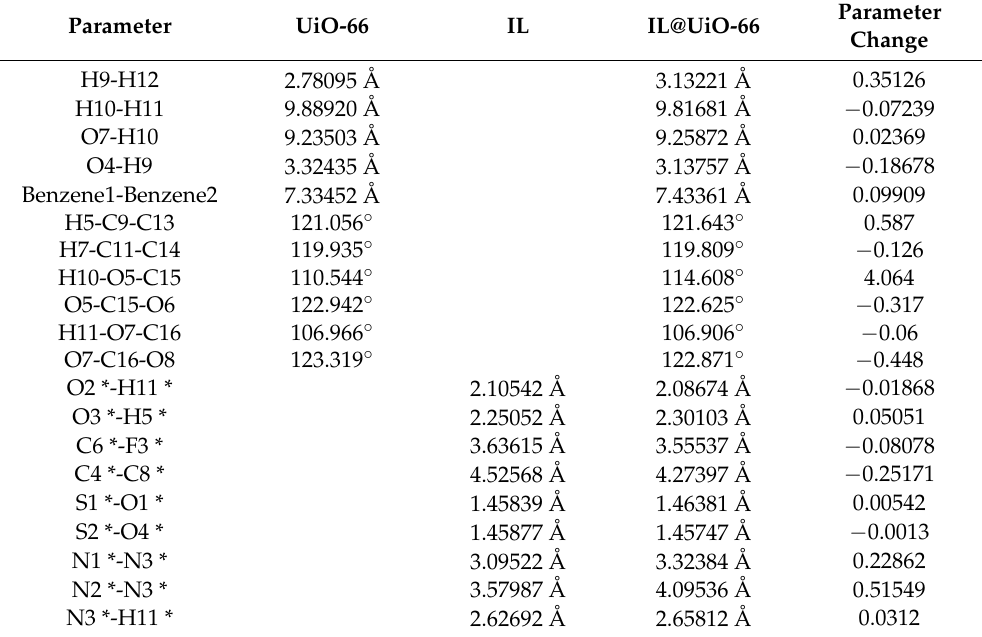
Table 2. The structural parameters of UiO-66, IL and IL@UiO-66.